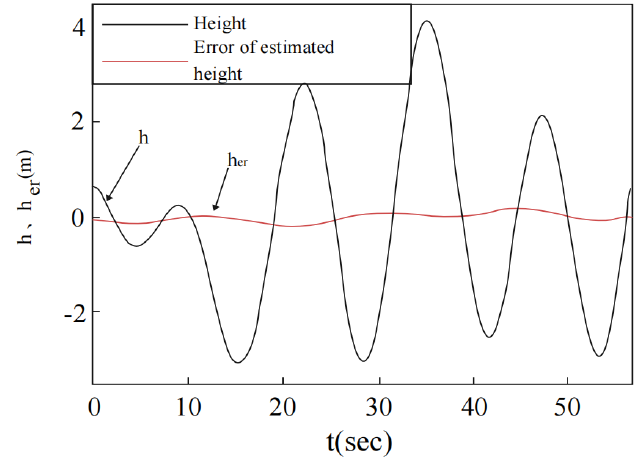
Figure 6. Height of ideal landing point and its estimated value (encounter angle of / 3  sea state, navigation speed of 18 knots).